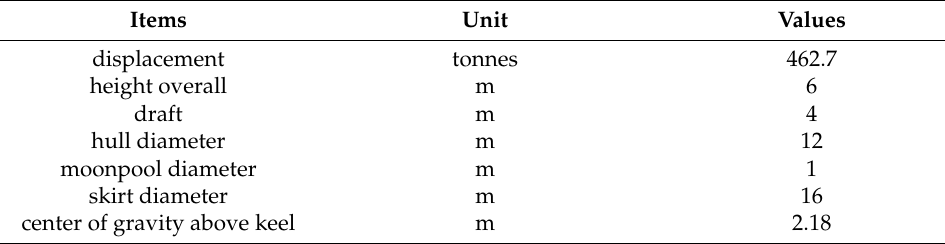
Table 6. Weathervaning mooring buoy details.